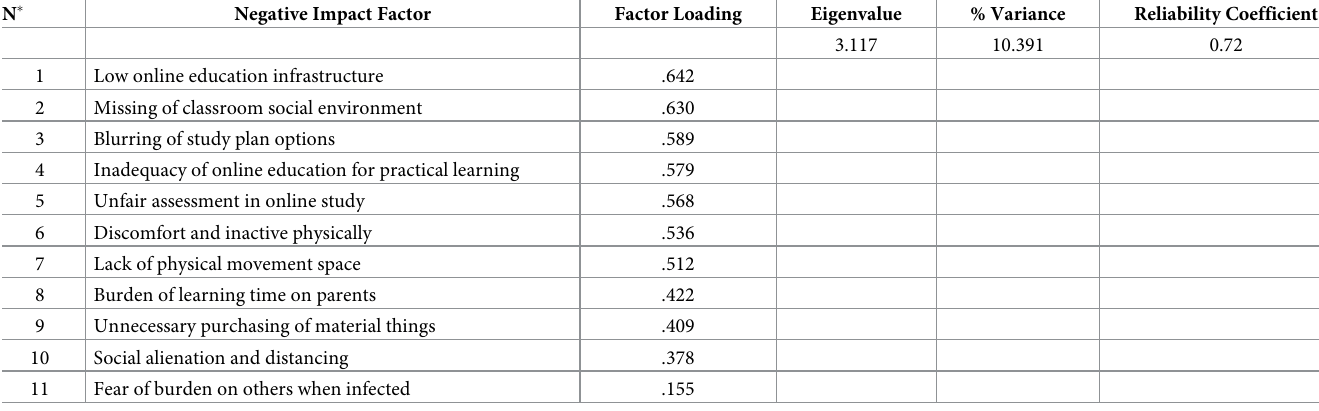
Table 3. Total variance explained by the factor of the negative impact of COVID-19 pandemic items.